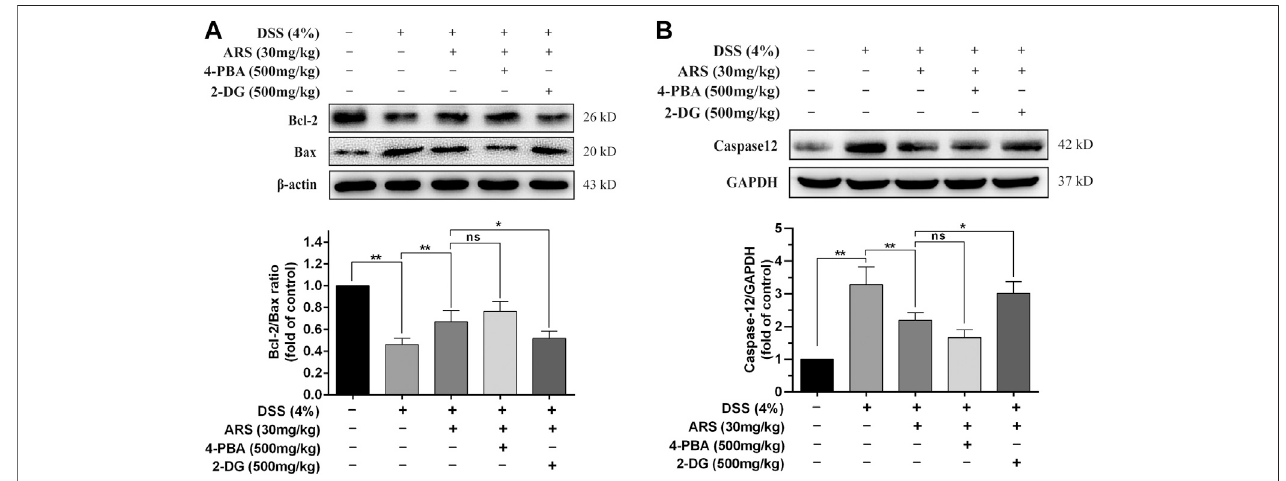
FIGURE 4 | 4-PBA and 2-DG affect the effectiveness of ARS on ER stress-related apoptosis. (A) Immunoblot analysis of Bcl-2/Bax ratio. (B) The expression of caspases12 was analysis by western blot. Data are presented as mean ± SD ( n (cid:1) 3). * p < 0.05, ** p < 0.01.